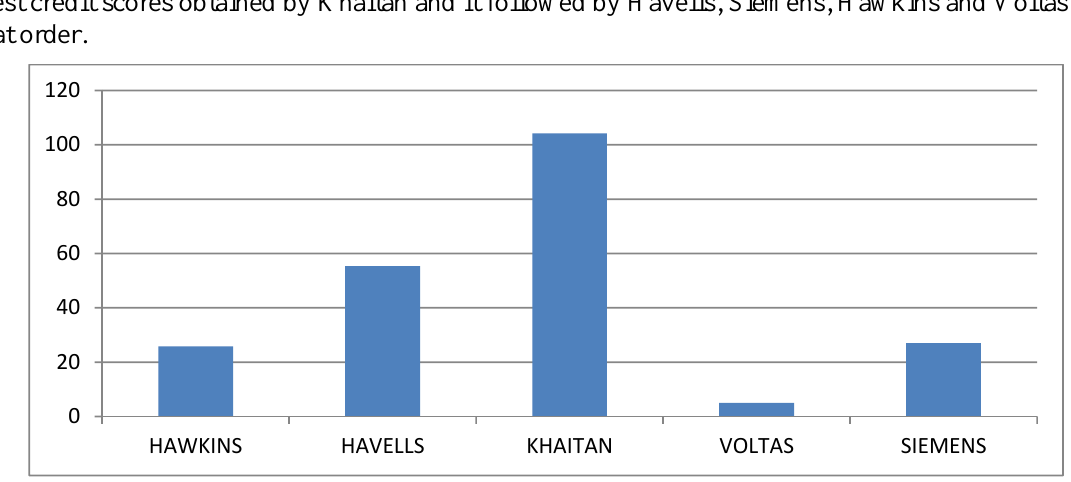
Fig. 3. Credit Scores of Consumer Durable